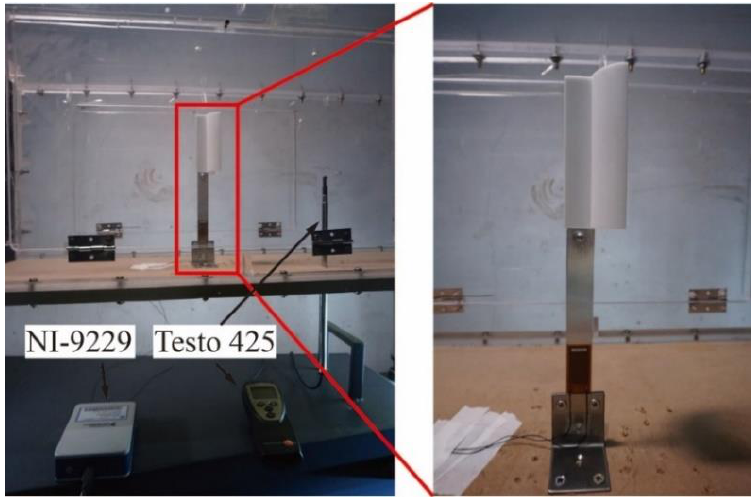
Figure 4. Configuration of piezoelectric wind energy harvesting test.